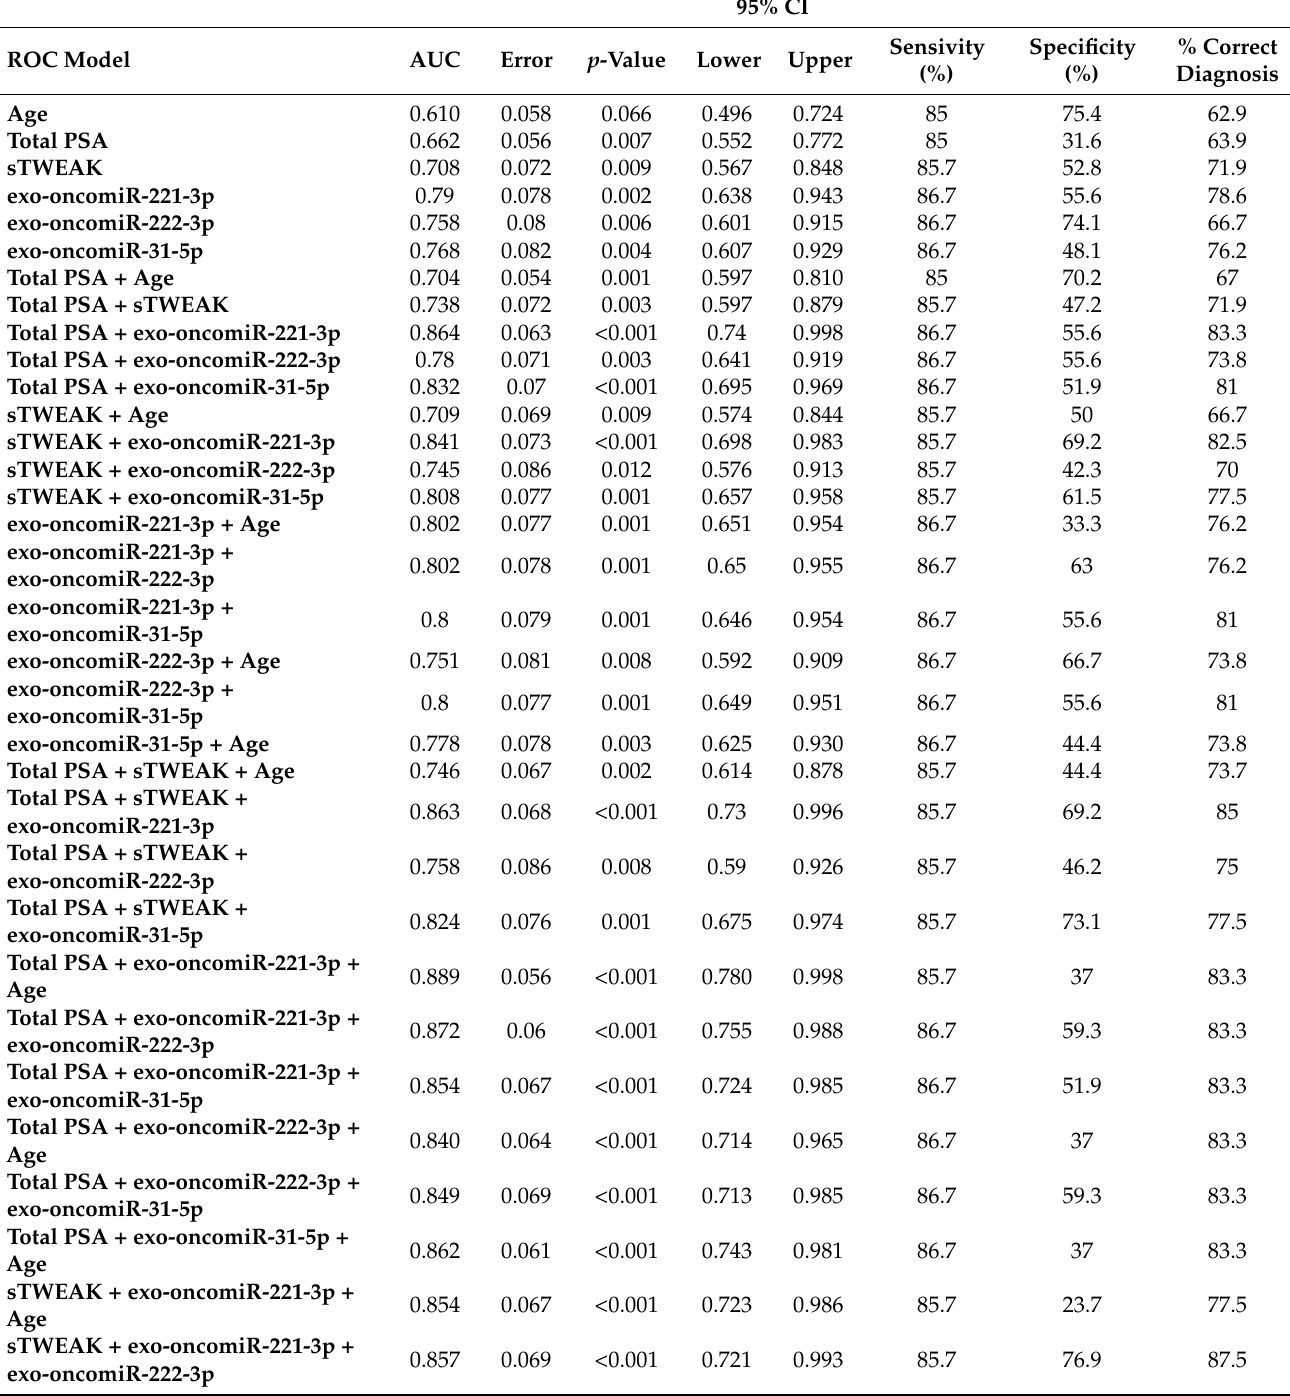
Table 3. Exo-oncomiRNAs-based models as diagnostic